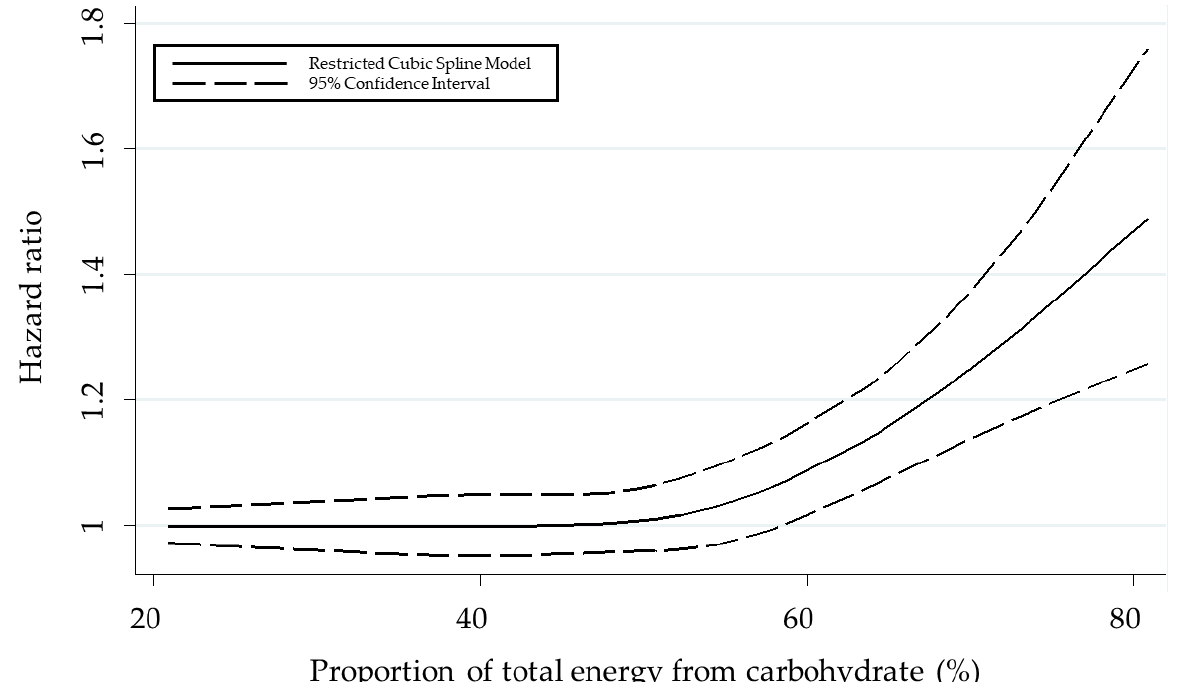
Figure 3. Dose–response analysis between carbohydrate intake and cardiovascular disease.